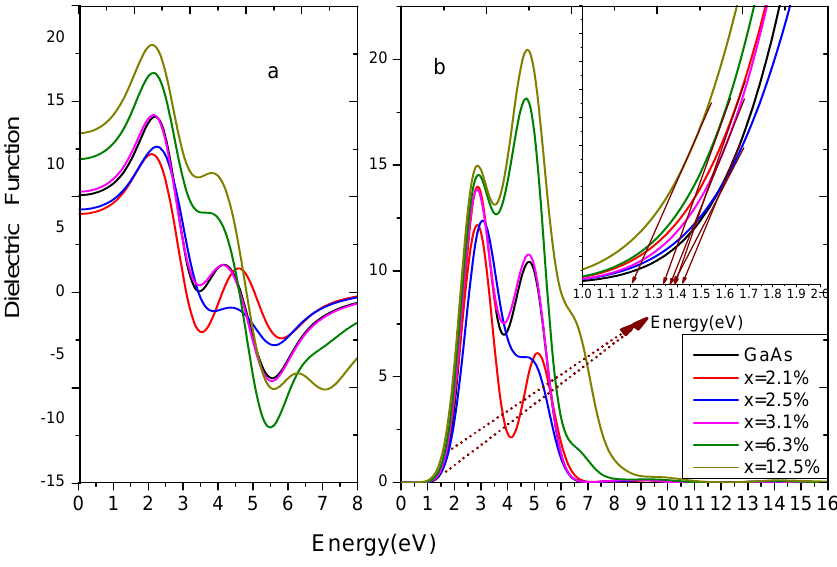
Table 2. The static dielectric constant ε